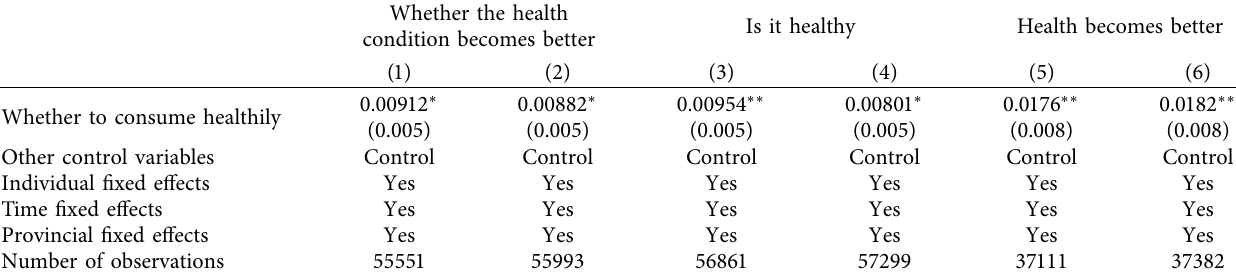
Table 5: Regression results under different variables.